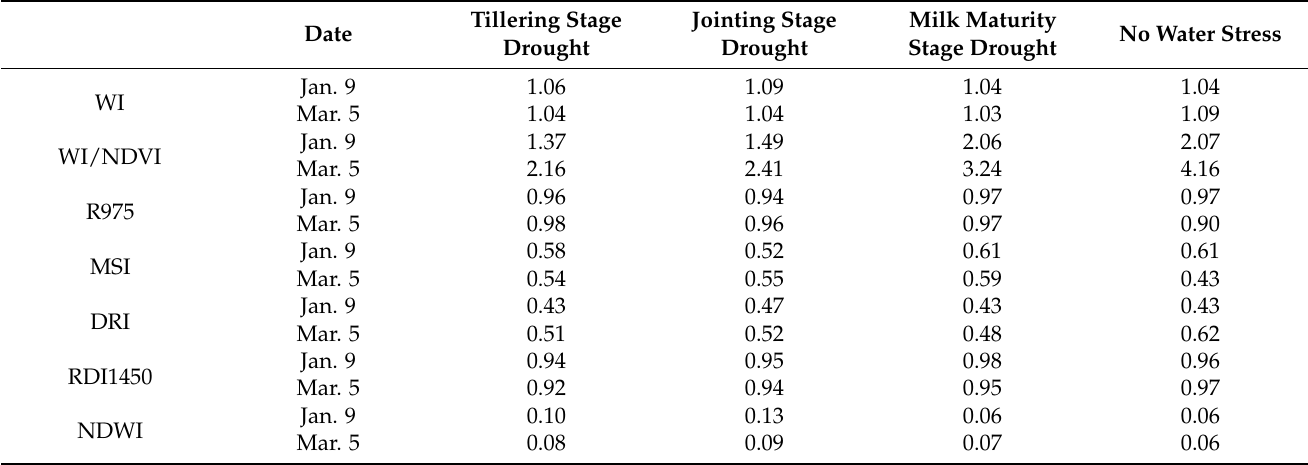
Table 6. Results with each VWI for different drought